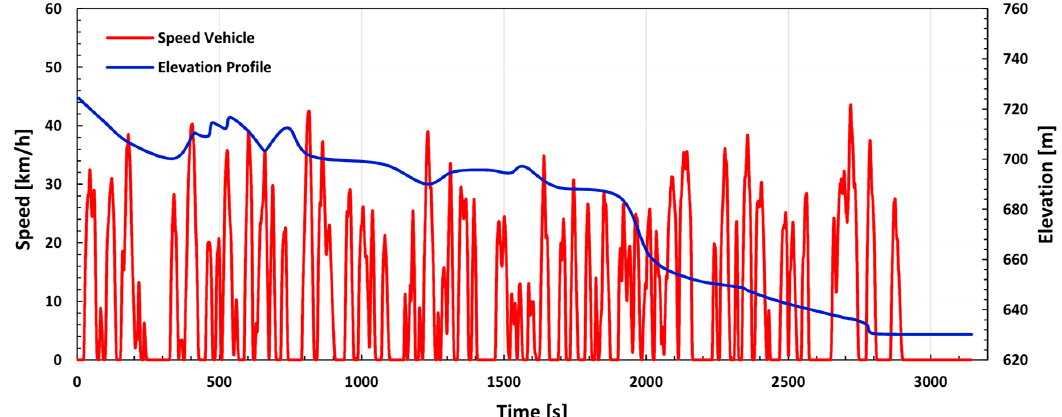
Figure 3. Actual speed and height profiles for a typical result along route 1.